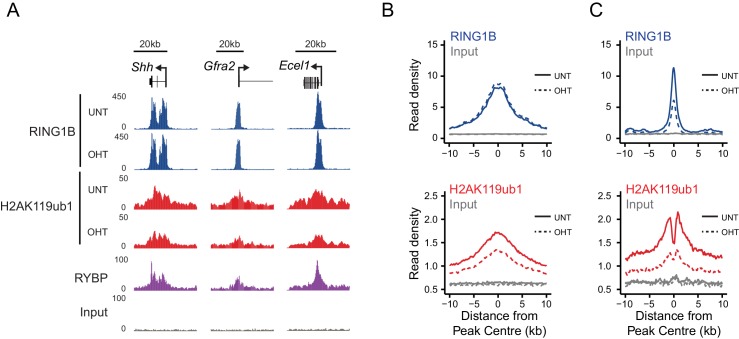
RYBP regulates the activity, not chromatin occupancy, of PRC1 in vivo.(A) A genomic snapshot of RING1B and H2AK119ub1 ChIP-seq in Rybpfl/fl;Yaf2−/− mouse embryonic stem cells before (UNT) and after 96 hr tamoxifen (OHT) treatment demonstrates that decreases in H2AK119ub1 occur in the absence of altered RING1B occupancy. (B–C) Metaplots illustrating H2AK119ub1 and RING1B ChIP-seq read density at H2AK119ub1 peaks with (n = 487) or without (n = 1870) significant reductions in RING1B occupancy before (UNT-solid line) and after tamoxifen treatment (OHT-dotted line). RYBP loss affects the levels of H2AK119ub1 (B-bottom panel) even though RING1B occupancy is unaffected (B-upper panel) indicating RYBP stimulates PRC1 activity at target sites in vivo.